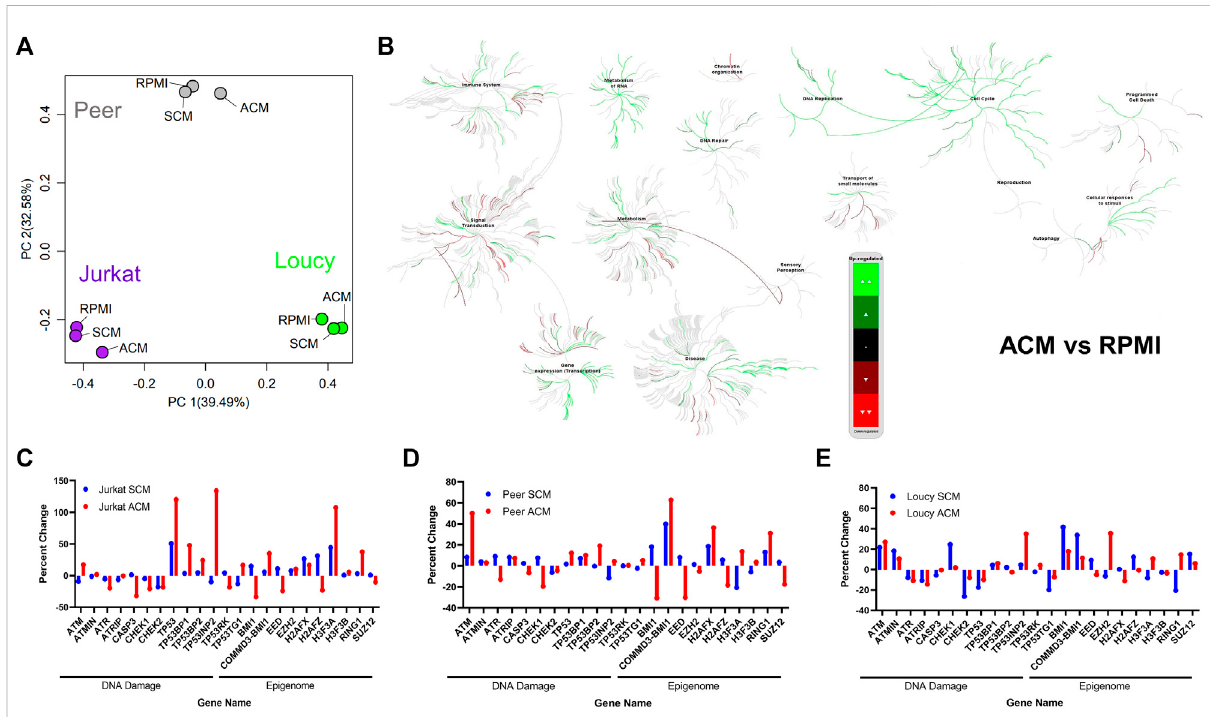
FIGURE 2 Adipocyte secretome induces gene expression programs in human T-ALL cells indicative of cell cycle progression, DNA damage, and altered epigenetics.RNA-sequencingwasperformedonhumanT-ALLcelllines(Jurkat,Loucy,andPeer)after24 hofcultureinunconditionedmediaRPMI, SCM, and ACM. (A) Principal component analysis (PCA) was performed to determine gene expression relationships between leukemia cell lines and culture conditions. (B) Data generated from the RNA-sequencing experiments were processed for pathway analysis using Reactome software. Pathways modulated by ACM relative to unconditioned media are shown. (C – E) Targeted analysis was performed for genes involved in the DNA damage response (DDR) and epigenetic stability. The fpkm value for each gene in T cells cultured in unconditioned media was used as the control value, and the data are graphed as the percentage increase or decrease relative to control values for each cell line under each